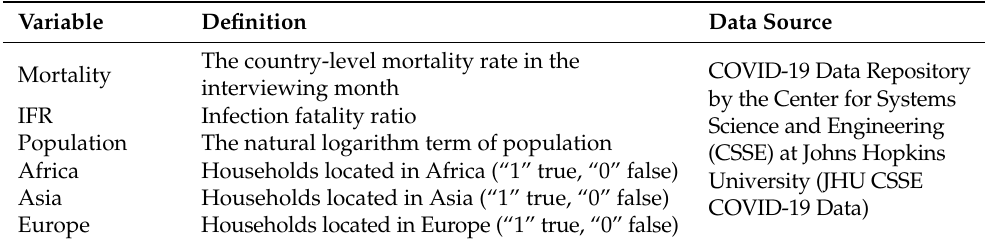
Table 1. Descriptions of the main